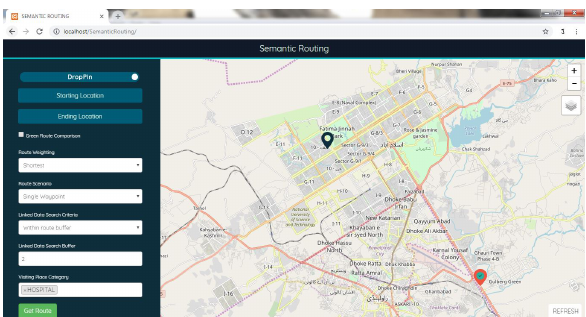
Figure 7. Marking origin and destination using the ’DropPin’